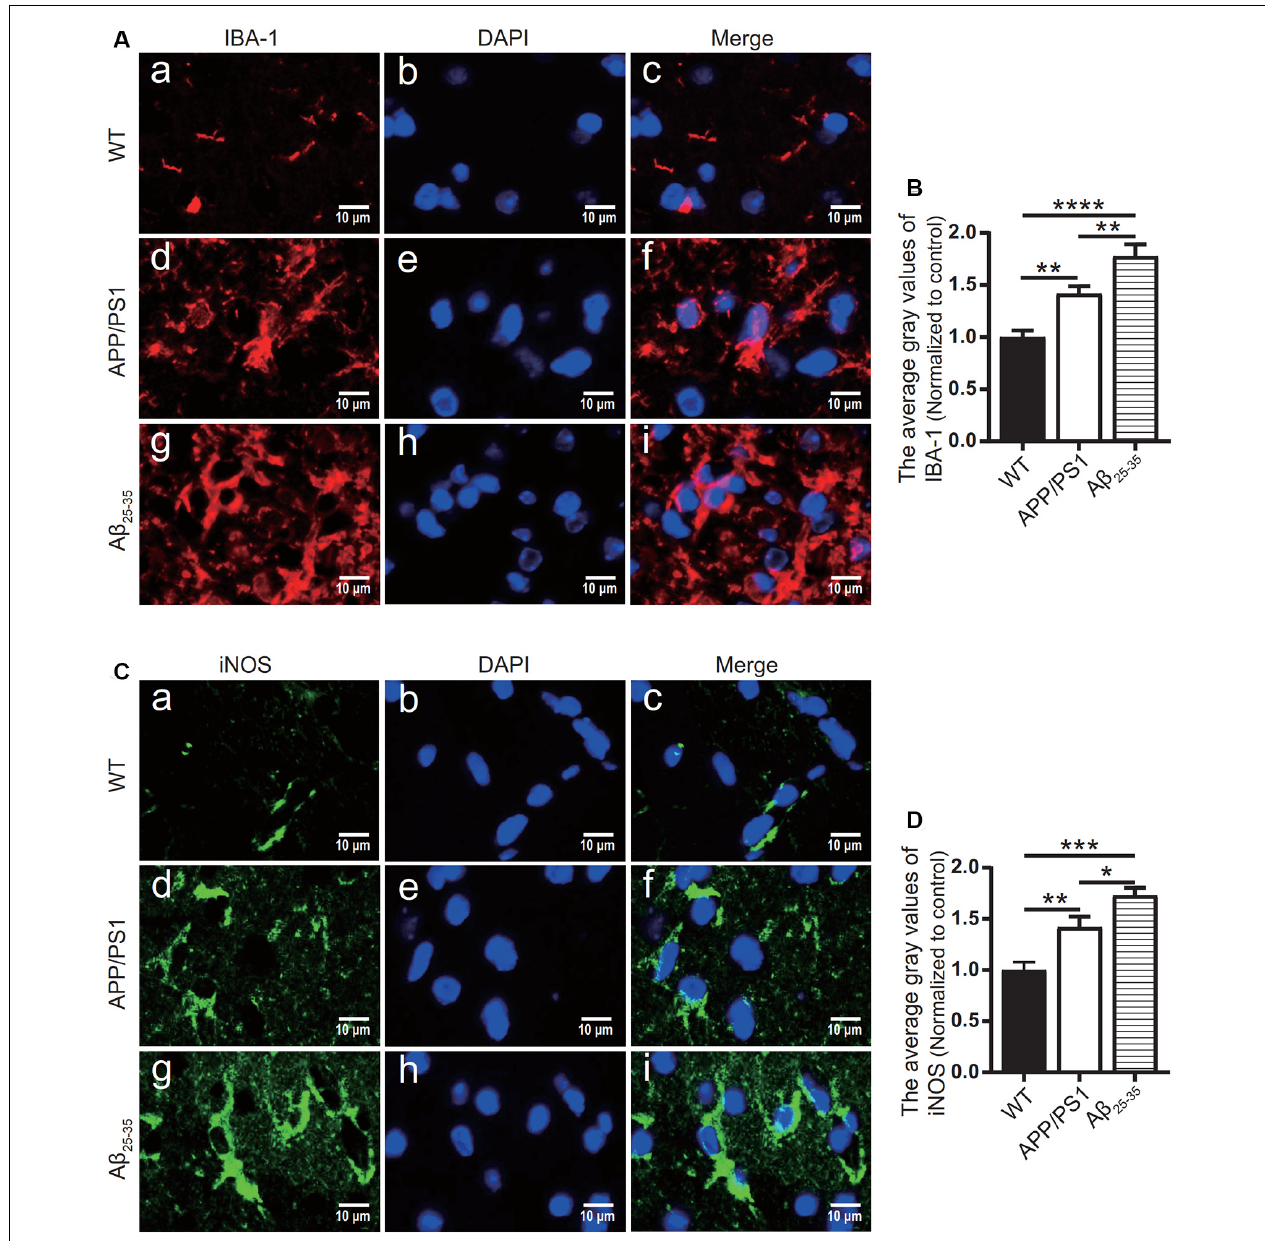
FIGURE 3 | Microglial marker proteins and inflammatory proteins were increased in AD model mice. (A,C) Immunofluorescence was used to analyze the microglial marker protein IBA-1 and inflammatory protein iNOS in the brain tissues of the WT group, APP/PS1 group, and A β 25–35 group mice. (B,D) The difference in fluorescence intensity between groups was compared (* p < 0.05, ** p < 0.01, *** p < 0.001, **** p < 0.0001; n =